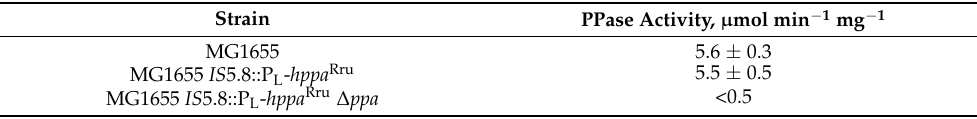
Table 3. Analysis of PPase activity in cytoplasmic fractions of E. coli strains expressing the hppa Rru gene in the presence and absence of E. coli ppa